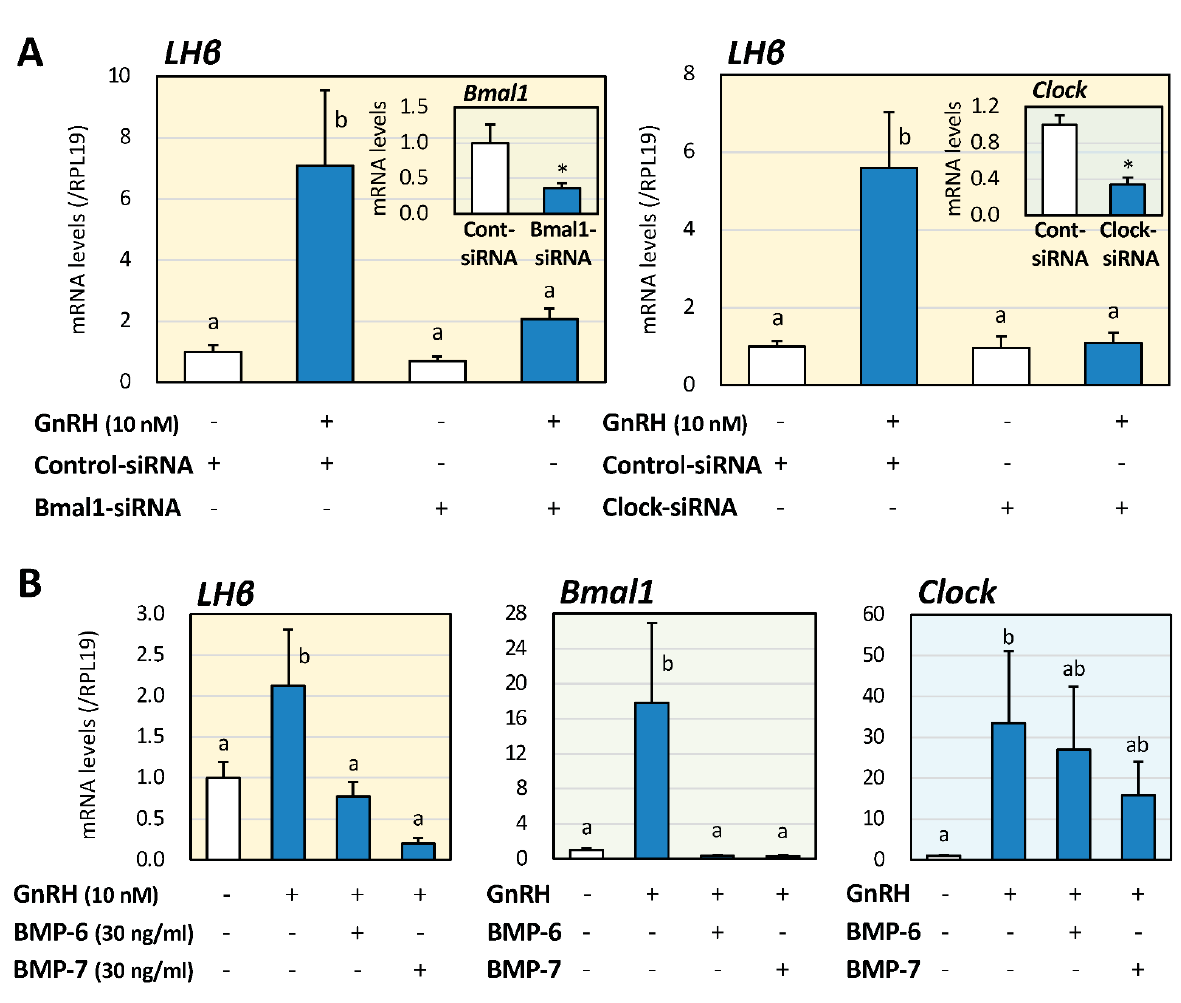
Figure 3. Effects of Clock gene suppression and BMPs on LH and Clock genes expression induced by GnRH in gonado- trope cells. ( A ) L β T2 cells (1 × 10 5 cells/mL) were transiently transfected with Bmal1- or Clock-specific RNA or control siRNA and then incubated with or without GnRH (10 nM) for 24 h. Total RNAs were extracted, and the mRNA levels of